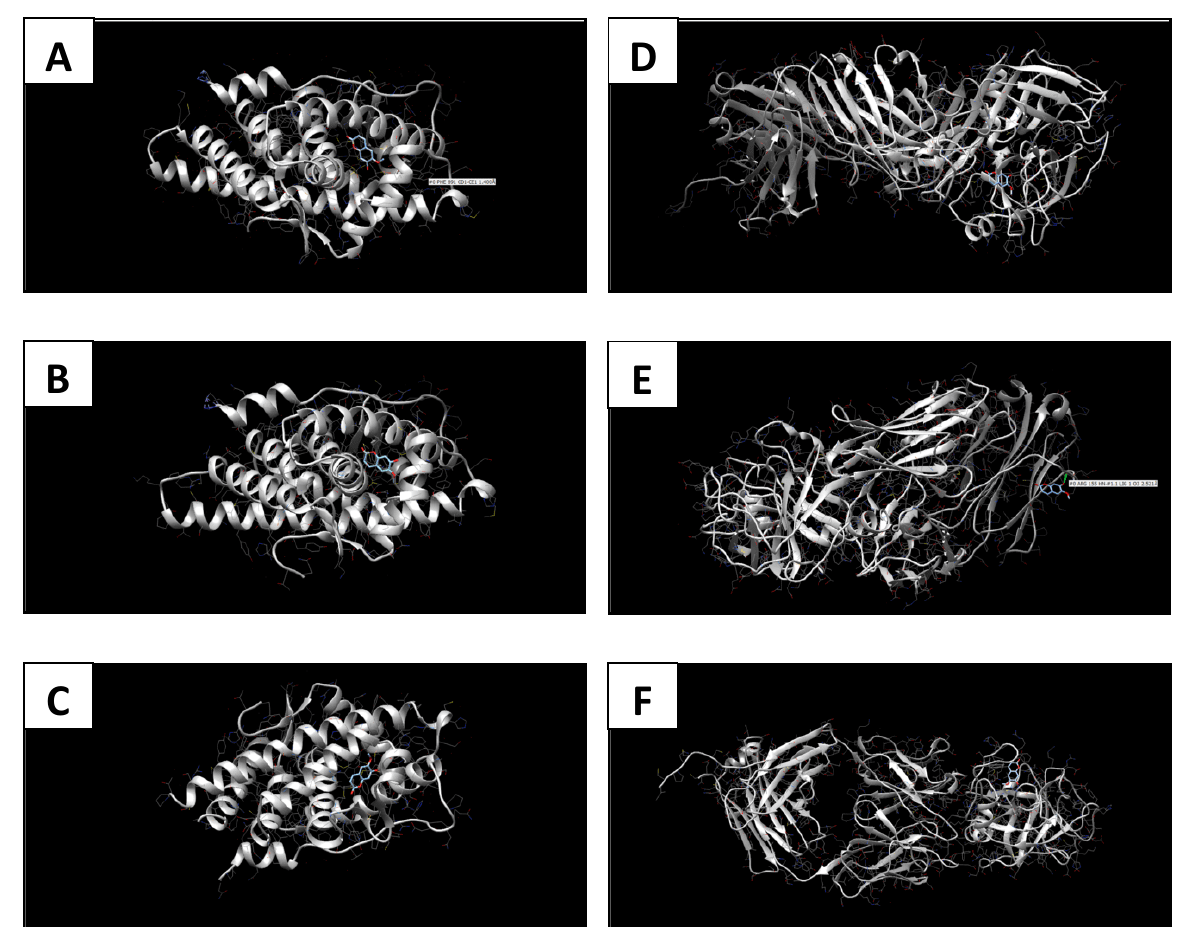
Figure 6. Molecular docking of scopoletin with androgen receptor (AR) PDB codes: 3RLJ (A), 5T8J (B), 5VO4 (C), and protein specific antigen (PSA) PDB codes: 2ZCH (D), 2ZCK (E), 2ZCL